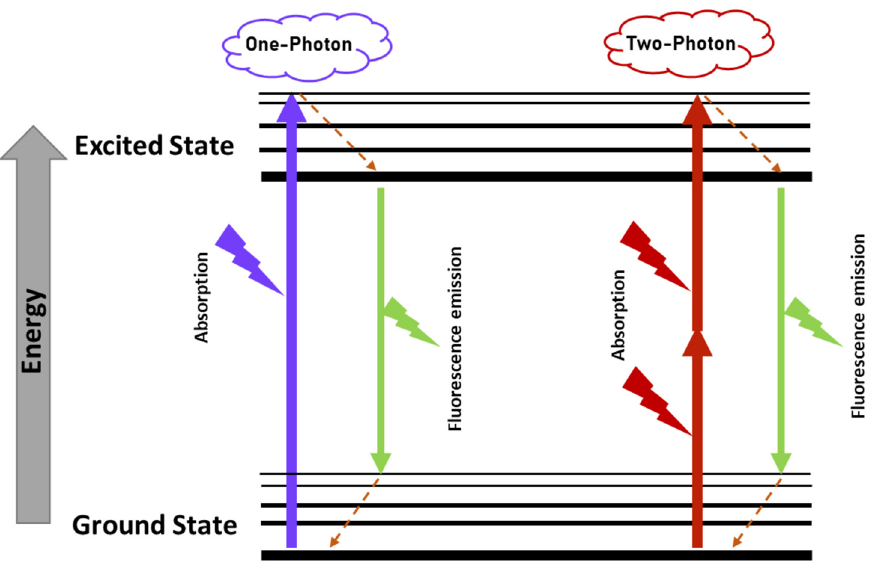
Figure 4. Jablonski diagram for one- and two-photon excitation fluorescence.